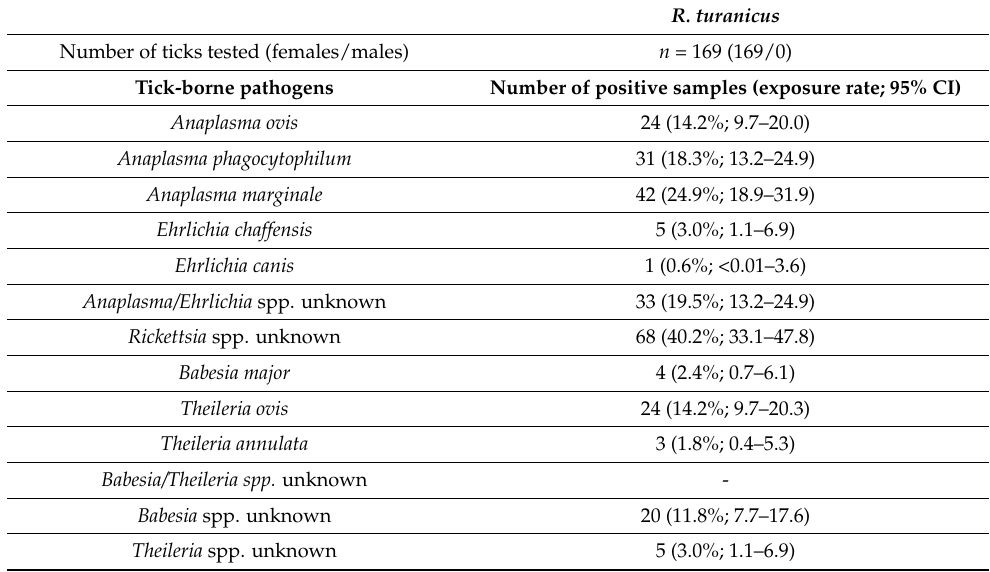
Table 4. Numbers and exposure rates (including 95% CIs) of single tick-borne pathogens detected in female Rhipicephalus turanicus ticks collected during the study (abbreviations: CI, confidence interval). R.